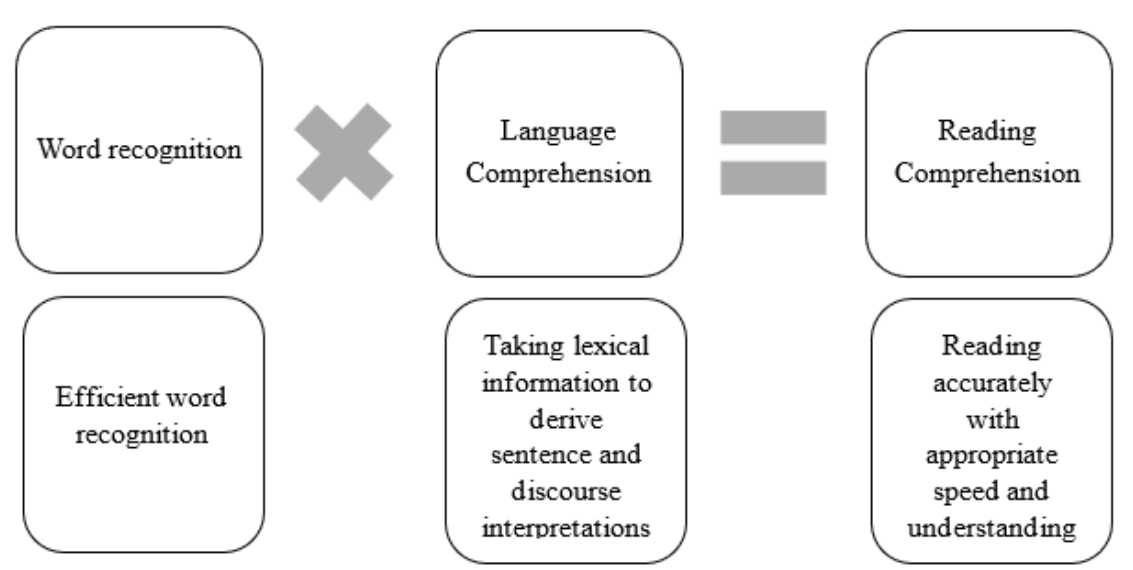
Figure 1. The Simple View of